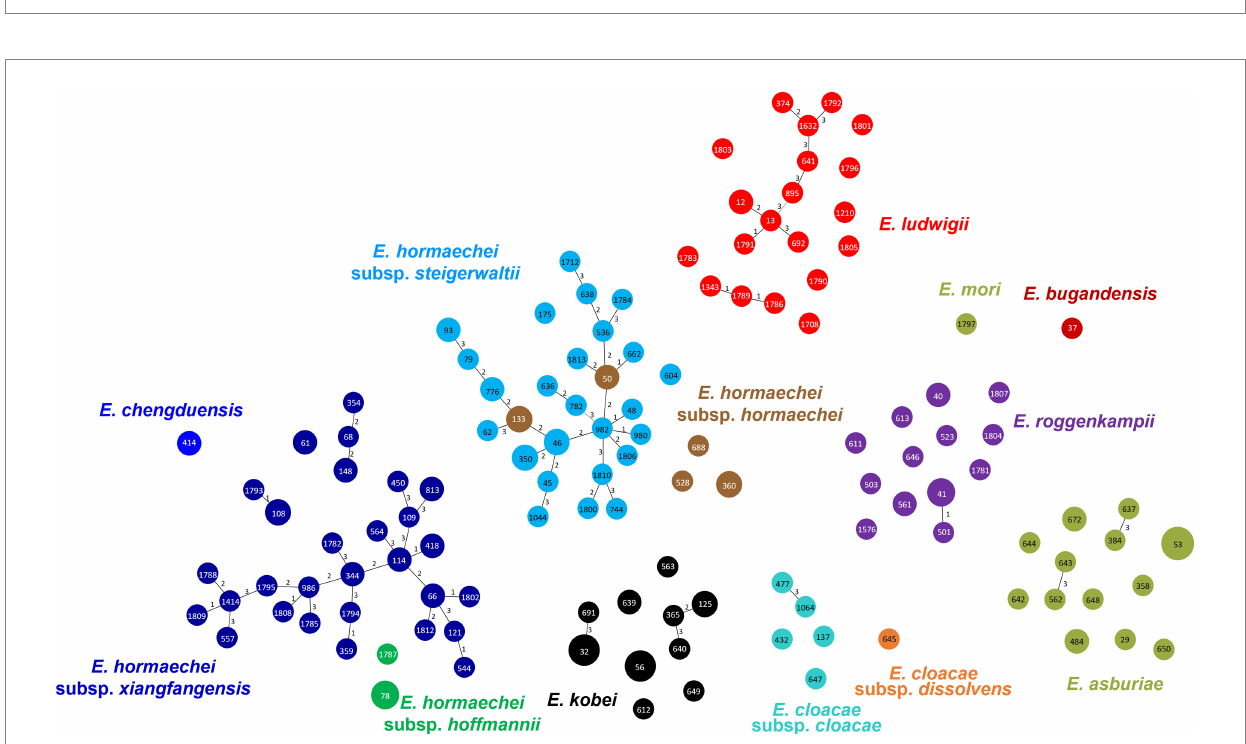
FIGURE 2 Minimum spanning tree of 183 clinical isolates of Enterobacter cloacae complex (ECC), based on the allelic profiles of multilocus sequence typing (MLST). Species based on the partial hsp60 sequences are shown in different colors. Each node within the tree represents a single sequence type (ST), and the length of branches between each node represents the number of different